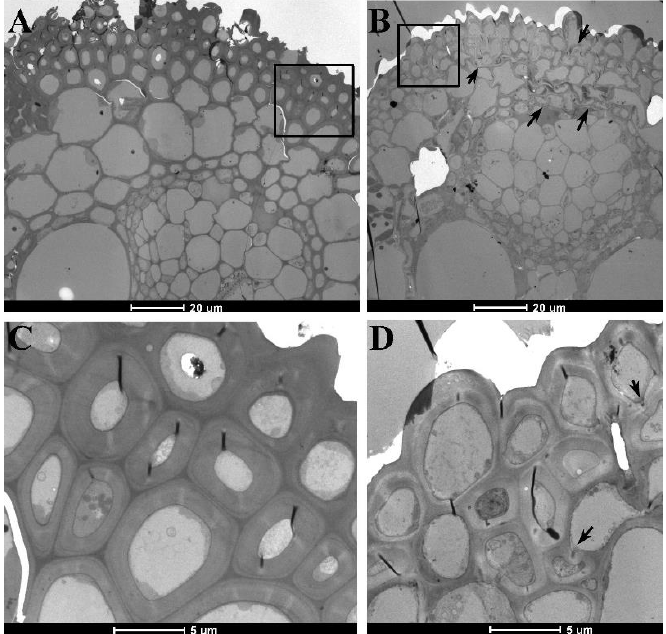
Figure 3. Electron microscopic observation of the sclerenchyma in the main leaf vein. Top of the main vein in leaves of RCCR1i ( A ) and df ( B ) plants. ( C , D ) Magnified sections of ( A , B ) showing the irregular shape and thin walls of sclerenchyma cells in the main leaf vein of df leaves. Arrows indicate the irregular shape cells.